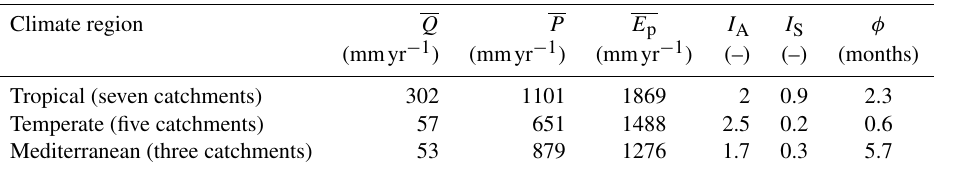
Table 1. Average hydrological characteristics of the catchments in the three climate regions for the time period 1973–2010 with long- term mean annual discharge Q , long-term mean annual precipitation P , long-term mean annual potential evaporation E p , aridity index I A = E p /P , and the seasonality index of precipitation I S = 1 monthly mean precipitation in month m (Gao et al., 2014); φ is the time lag between long-term mean maximum monthly precipitation ( P ) and potential evaporation ( E p ). Values for all individual catchments are provided in Table S2.